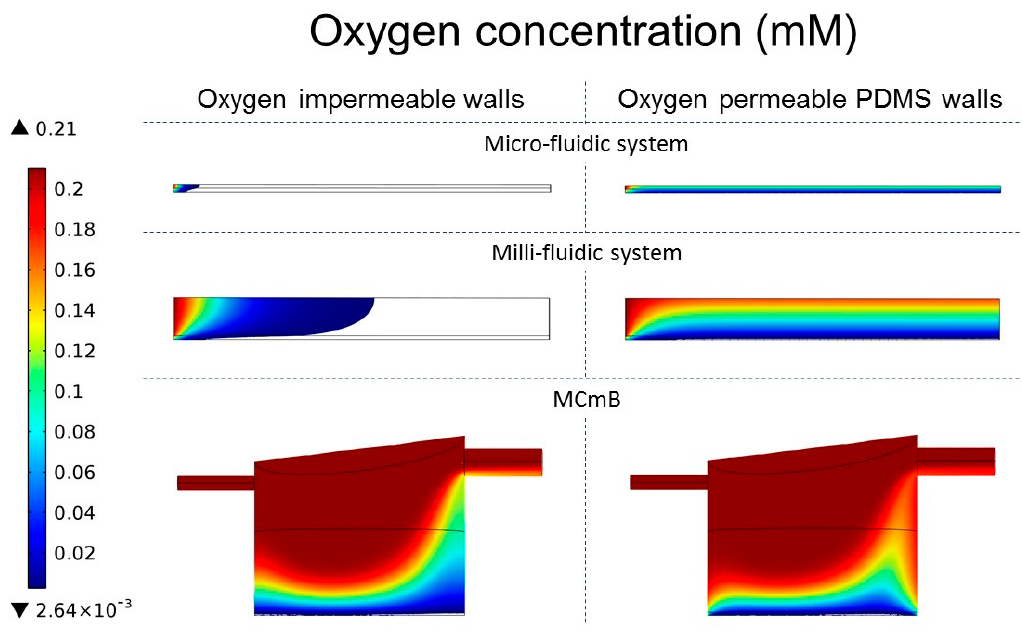
Figure 9. Oxygen concentration profiles in the three modelled systems. Hypoxic regions where are represented in white. 𝑐 𝑂 2 < 𝑐 𝑐𝑟